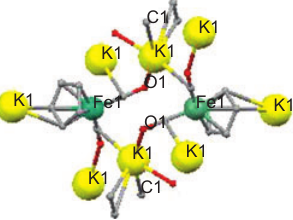
Figure 5 View of the (cp)Fe(CO Schnering, 1991